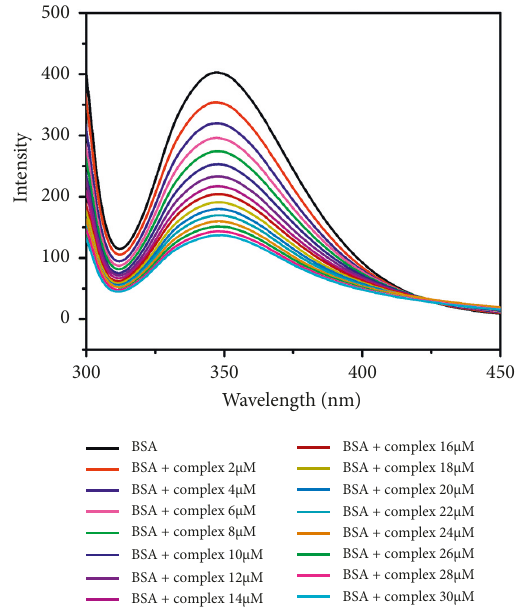
Figure 11: Fluorescence spectra of BSA (2 μ M) with complex 1 (0–30 μ M) in PBS buffer (pH 7.4).